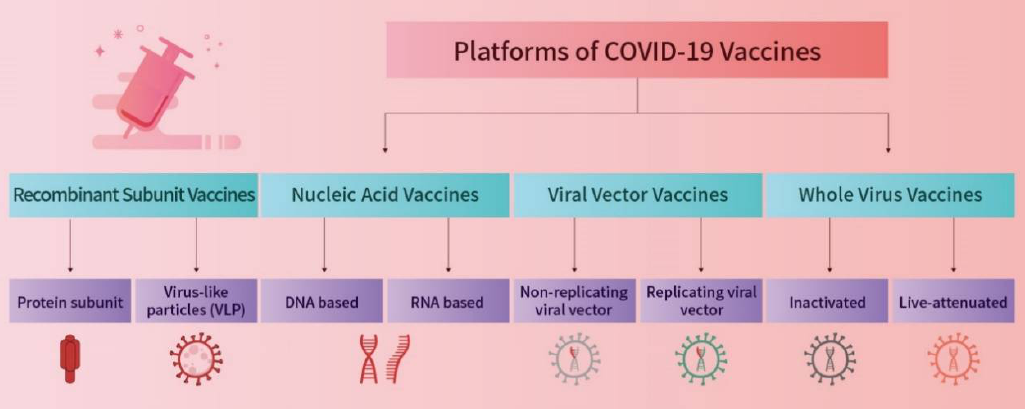
Figure 2. A schematic diagram showing the different vehicles used to combat the COVID-19 virus. [26] .